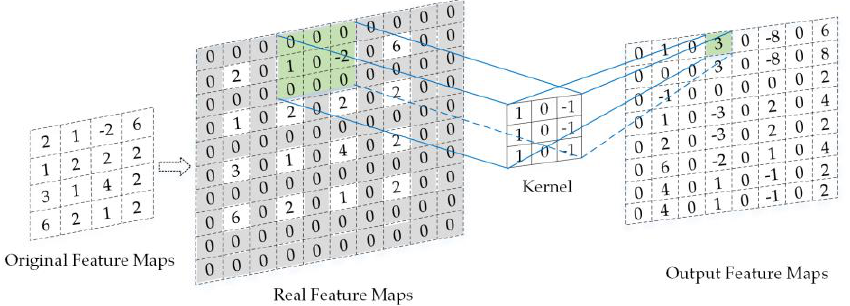
Figure 3. The computation of the transposed convolution ( pad in = 1, pad out = 1, s = 2).